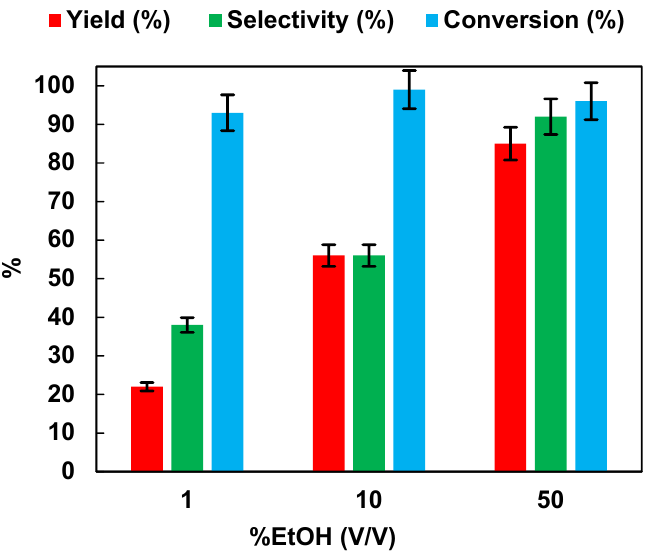
Figure 4. Effects of the EtOH% ( v / v ) in aqueous solution on the photocatalytic reduction of NB to AN using P25. Reaction conditions: NB 1 mmol/L; solution volume 100 mL; 0.5 g/L TiO 2 (P25); temperature 25 °C; UV irradiation time t is 45 min. Error bar ±5%.